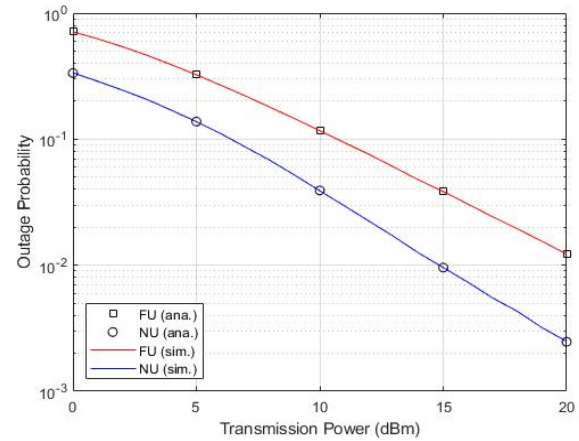
Figure 13. User OP versus transmission power.